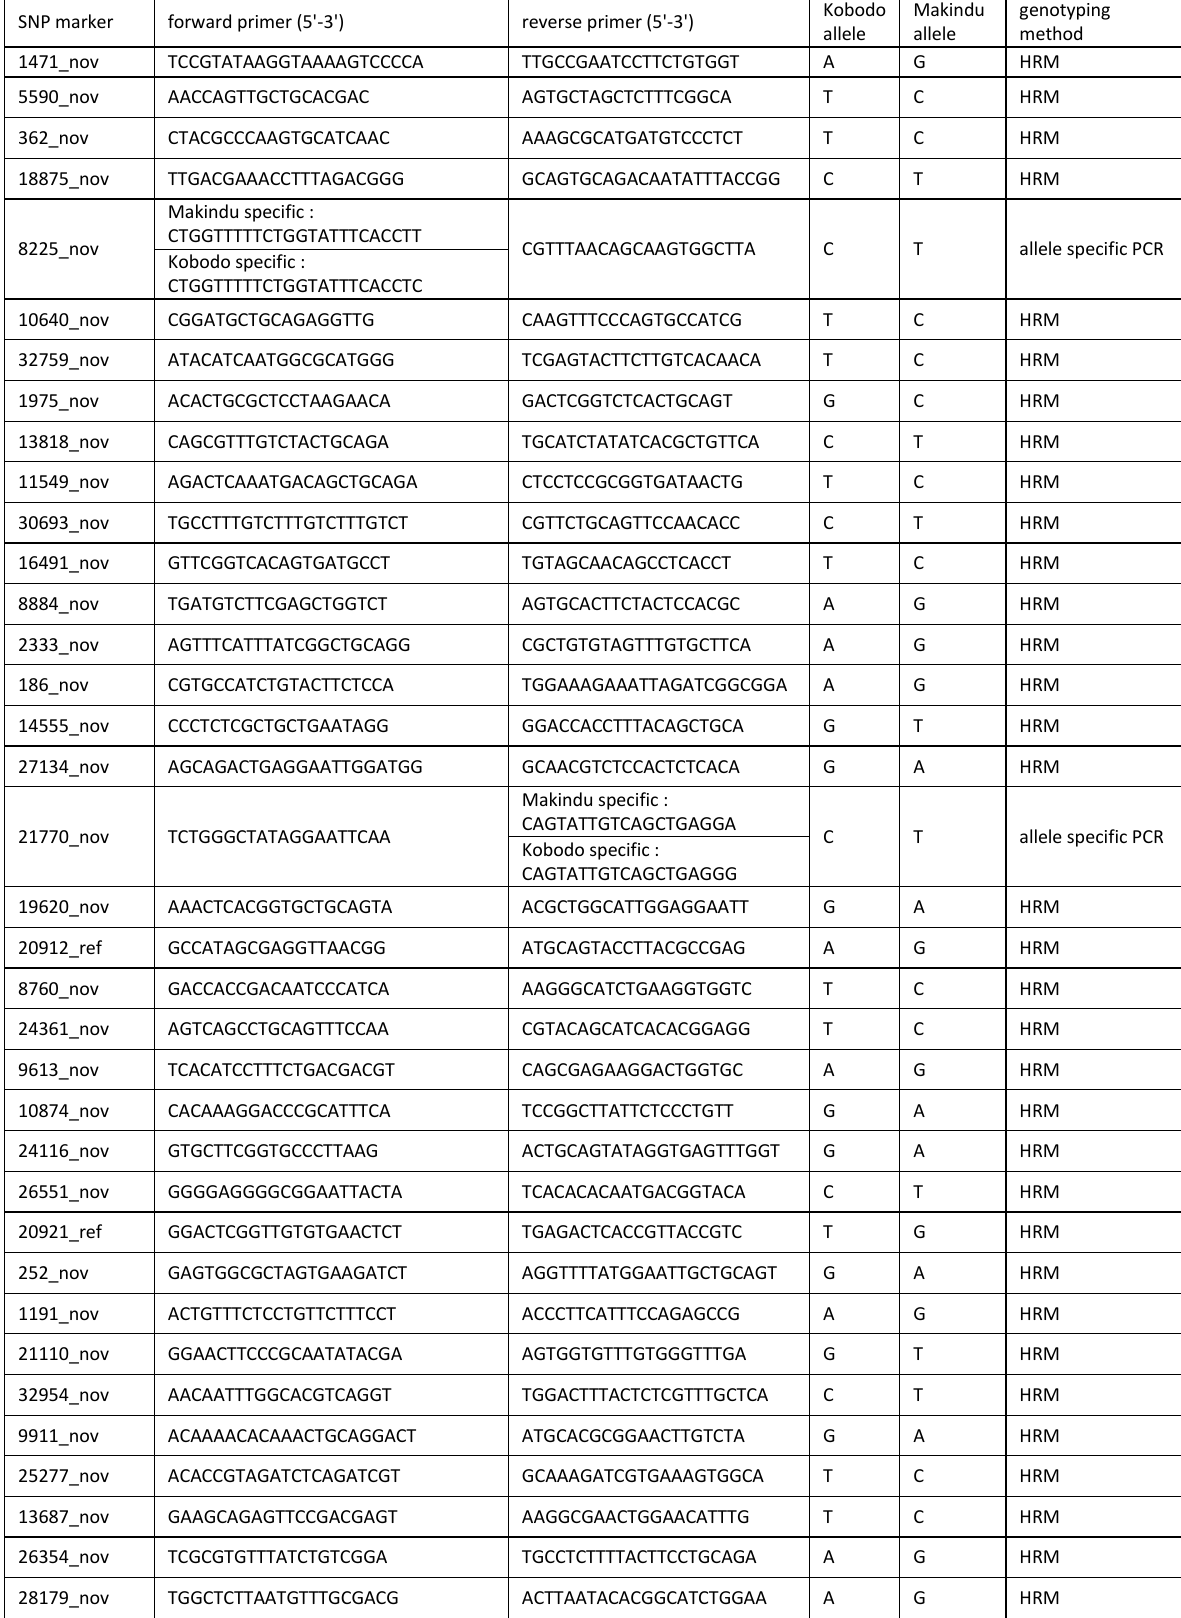
Supplementary Table 2: Primers’ sequences for the 63 SNP markers used for genotyping. The Kobodo and Makindu reference alleles are also indicated for each